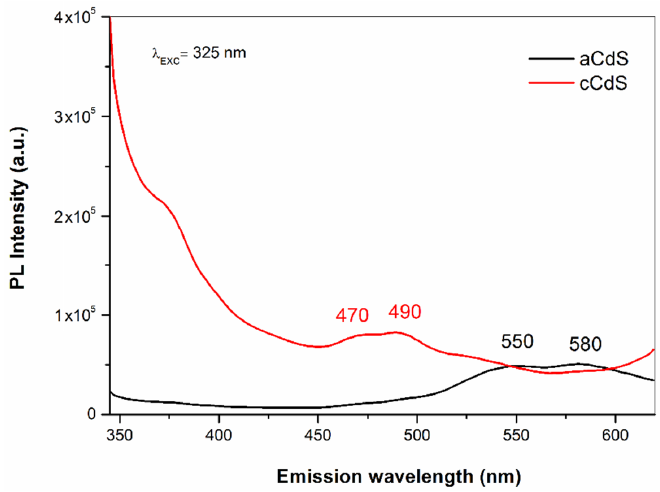
Figure 6. PL emission spectra of aCdS and cCdS samples.